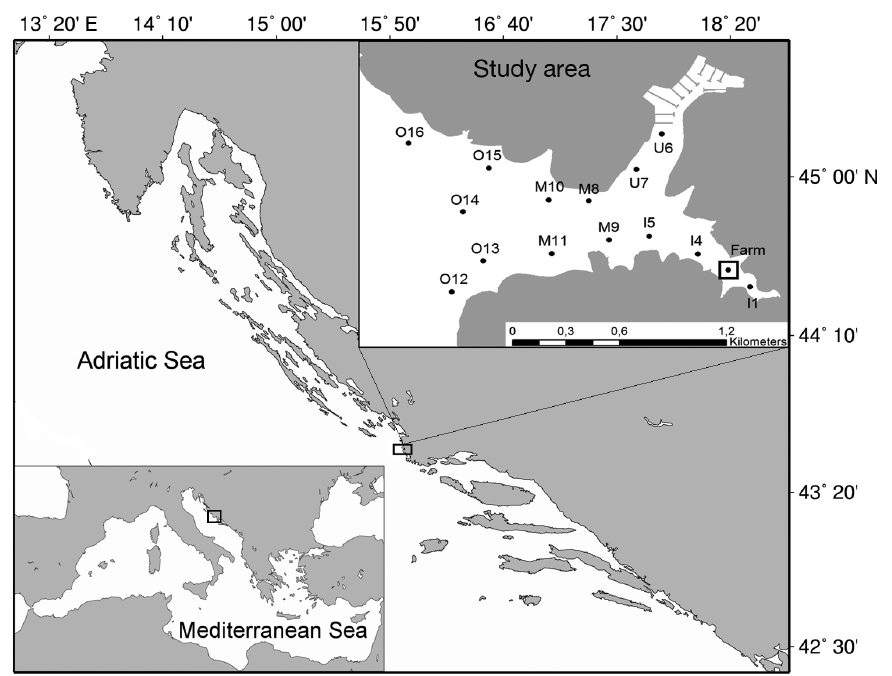
Fig. 1. Adriatic coast of Croatia. Lower left: Mediterranean. Upper right: study area in Peles Bay, with receiver locations ( d ) in the farm-impacted area (receivers: ‘Farm’, I1, I4, and I5), middle part of the bay (M8, M9, M10, M11, U6, and U7), and outer part of the bay (O12, O13, O14, O15, and O16). See also Table S1 in the Supplement at www.int-res.com/ articles/ suppl/ q010p021_ supp.